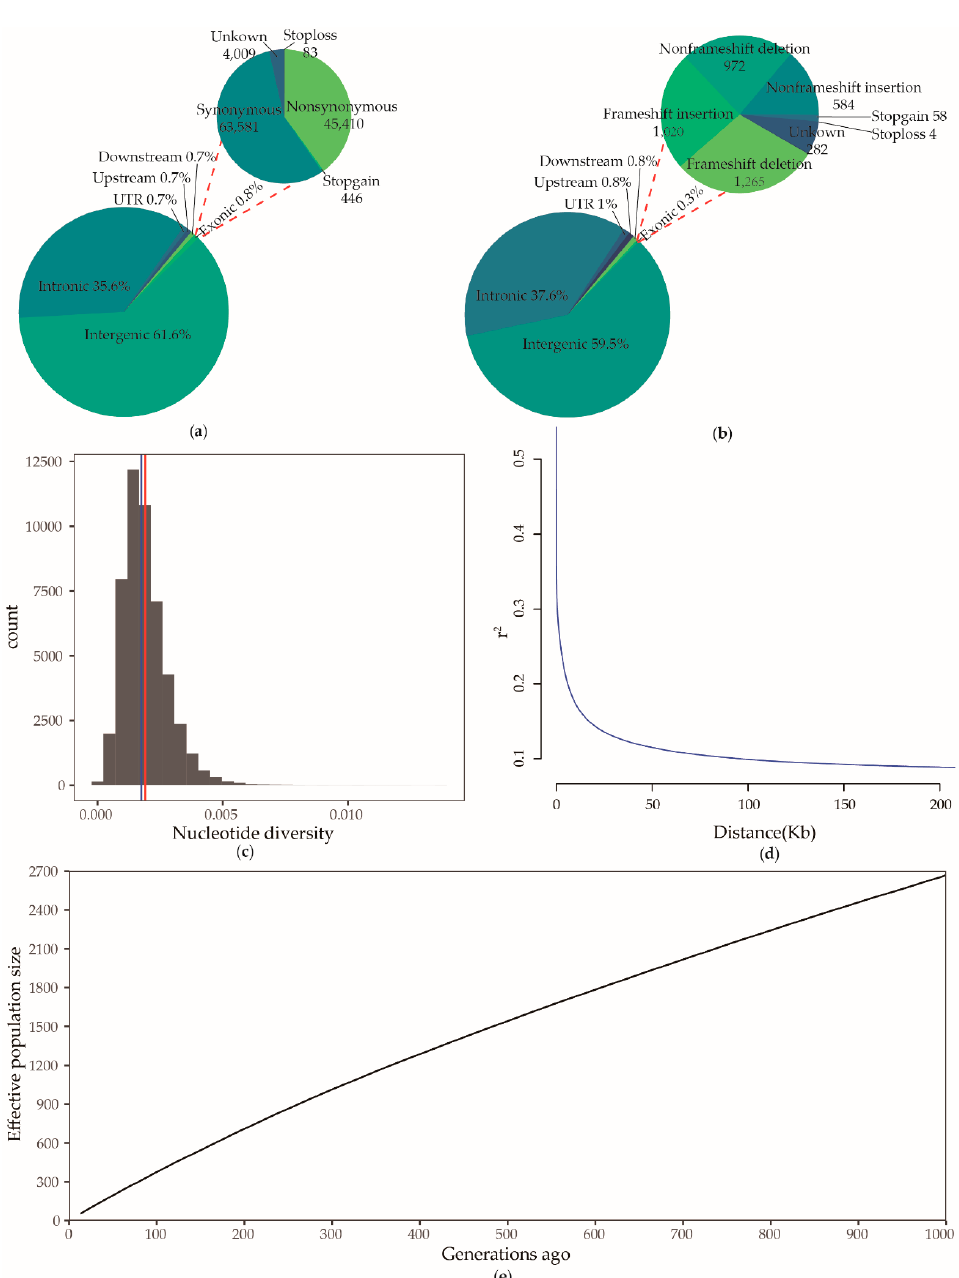
Figure 2. Identification of genomic characteristics. ( a ) Functional classification of the detected single nucleotide polymorphisms. ( b ) Functional classification of the detected indels. ( c ) Distribution of nucleotide diversity in non-overlapping windows of 50 kb across the autosomes. The red line and blue line indicate mean and median, respectively. ( d ) Genome-wide average linkage disequilibrium (LD) decay in the Du’an goat. ( e ) E ff ective population size over the past 1000